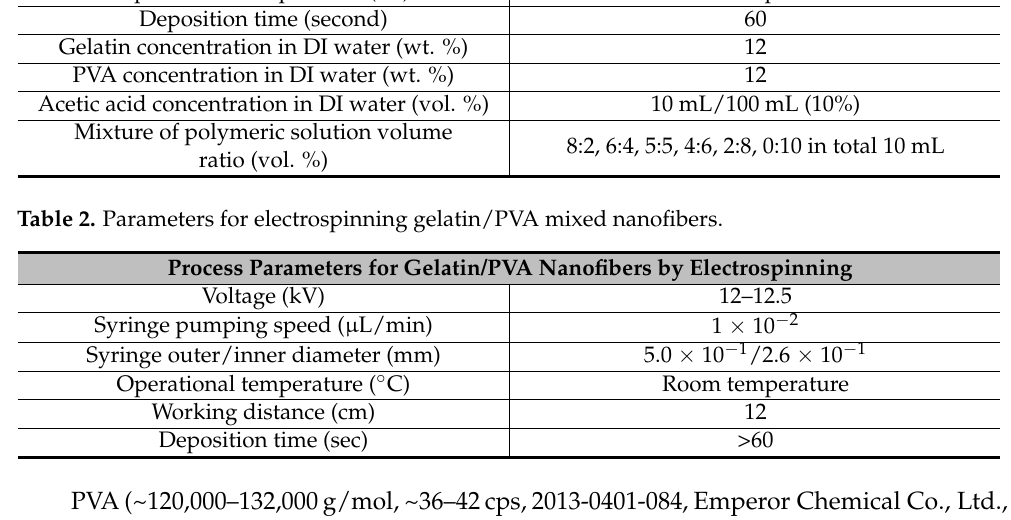
Table 1. Parameters for spin coating of gelatin/PVA mixed layer film. Process Parameters for Gelatin/PVA Films by Spin Coating Speed (rpm) 3000 Operational temperature ( ◦ C) Room temperature Deposition time (second) Gelatin concentration in DI water (wt. %) PVA concentration in DI water (wt. %) Acetic acid concentration in DI water (vol. %)